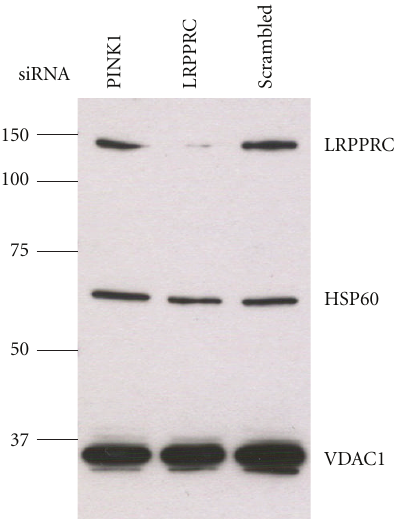
Figure 2: Specificity of an anti-LRPPRC antibody. Fibroblasts were incubated with PINK1 siRNA, LRPPRC siRNA, or scrambled siRNA for 24h. Whole cell lysates were analyzed by Western blotting with an antibody against LRPPRC. LRPPRC levels decreased only when LRPPRC siRNA was employed, confirming the specificity of the anti-LRPPRC antibody used in our study. The mitochondrial markers HSP60 and VDAC1 served as loading controls. HSP60: Heat shock 60kDa protein; LRPPRC: Leucine-rich PPR motif- containing protein; VDAC1: Voltage-dependent anion channel